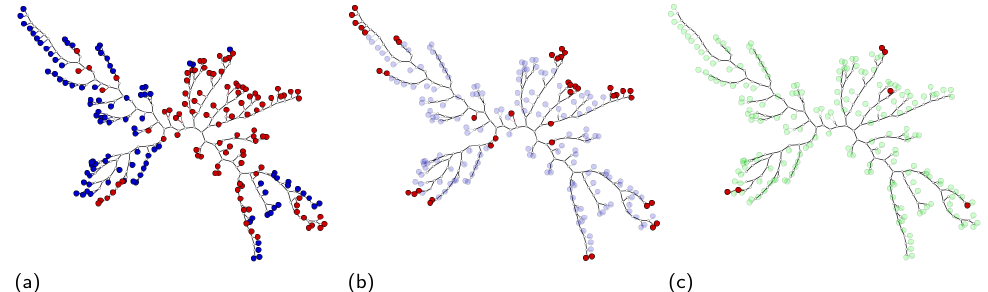
Figure 5. MILTree’s bag space layout for a subset of the Corel-1000 dataset (100 images of the horse category and 100 random images selected from the remaining categories), with the projection of its ground truth ( a ), selected training set ( b ) and InstancePrototypes ClassMatch tree ( c ).